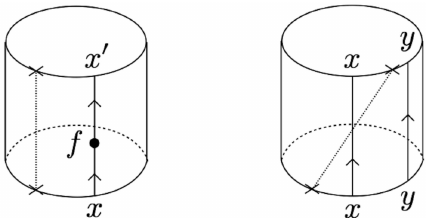
Figure 3 . There are two types of transition amplitudes for a cylinder. The left figure represents the transition amplitude Z ( f ) : V corresponding to a topological point operator f ∈ Hom( x, x 0 ) . x → V x 0 The right figure represents the transition amplitude X : V corresponding to a change xy x ⊗ y → V y ⊗ x of the base point.